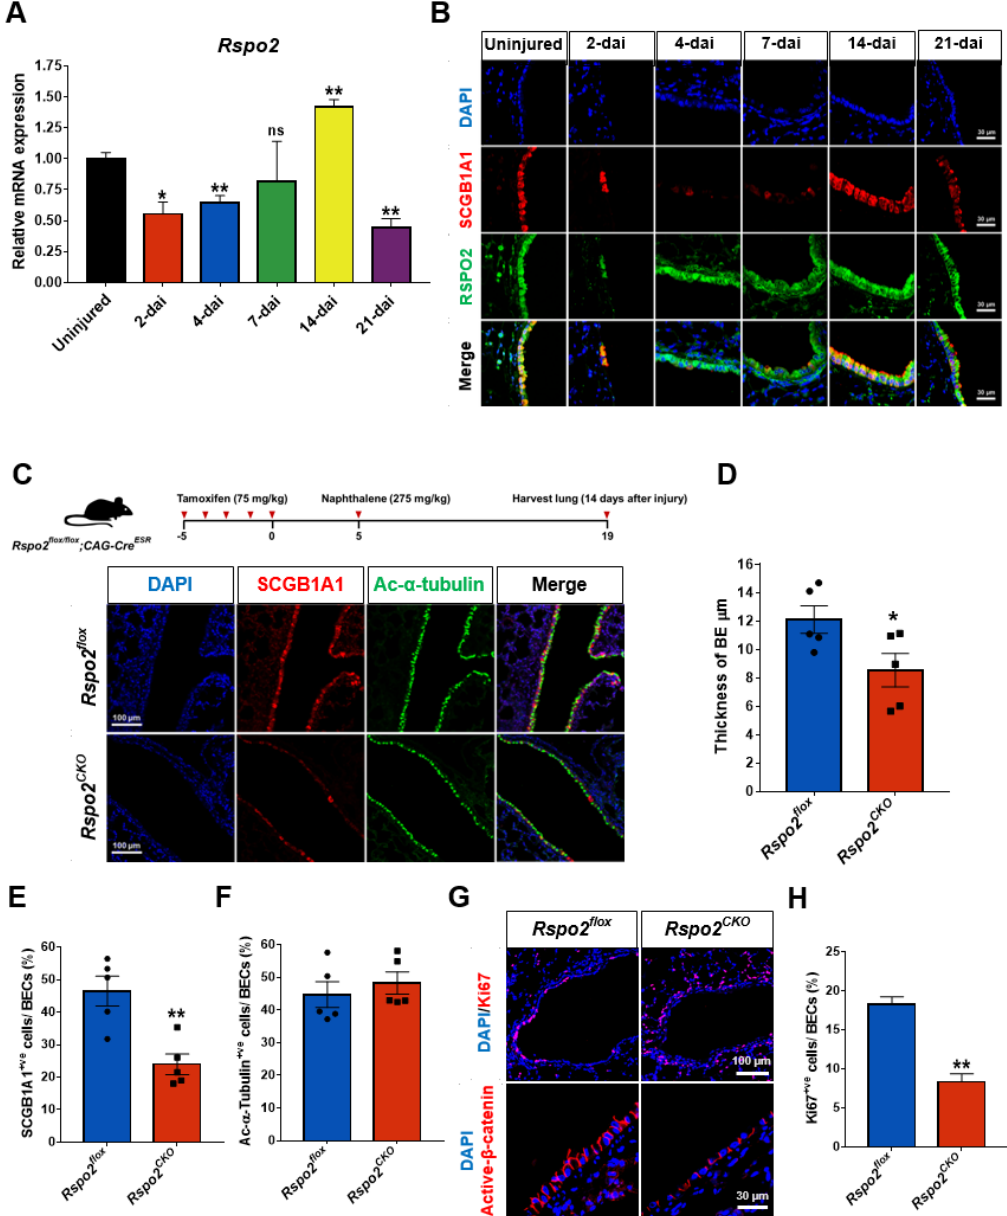
Figure 7. Rspo2 gene ablation causes defects in airway regeneration after naphthalene-induced acute lung injury . ( A ) Rspo2 expression during airway regeneration in naphthalene-induced lung injury by qRT-PCR. dai; days after injury. ( B ) Immunofluorescence staining of RSPO2 and SCGB1A1 during airway regeneration. ( C ) Schematic diagram of the experimental schedule for conditional Rspo2 knockout followed by naphthalene-induced acute lung injury, and the expression of SCGB1A1 and Ac- α -tubulin determined by immunofluorescence staining of Rspo2 CKO lung tissues at 14 dai. ( D ) Measurement of the thickness of the bronchiolar epithelium at 14 dai in Rspo2 CKO lungs. ( E , F ) The percentage of SCGB1A1 +ve club and Ac- α -tubulin +ve ciliated cells in the bronchiolar epithelium at 14 dai in Rspo2 CKO lungs. ( G , H ) Immunofluorescence staining of Ki67 and active β -Catenin at 14 dai in Rspo2 CKO lung tissue and quantification of Ki67 +ve proliferative cells. Data were collected from the samples ( n = 4 for Rspo2 CKO and control mice each) and are presented as mean ± SEM. ns: no statistical significance, * p < 0.05, ** p <